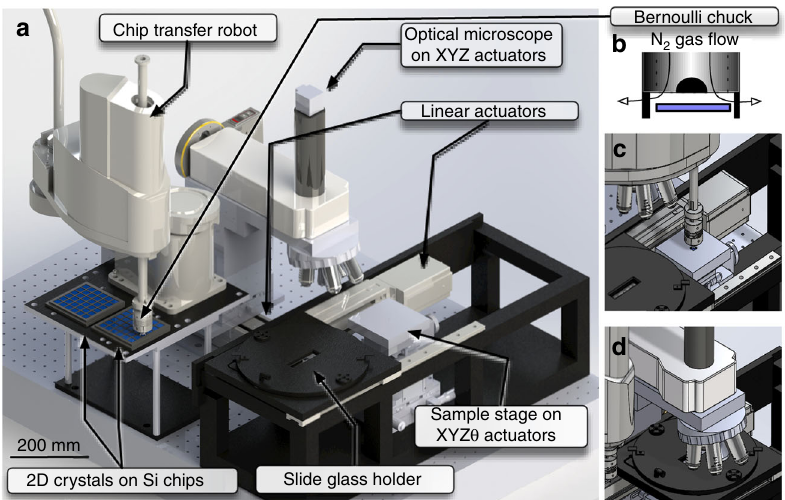
Fig. 6 The automated stamping system. a Schematic of automated stamping system. b Schematics of robot arm end effector; Bernoulli-type fl oating chuck. c , d Schematics of the automated stamping procedure: transferring SiO 2 /Si chips by robotic arm and setting optical microscope,